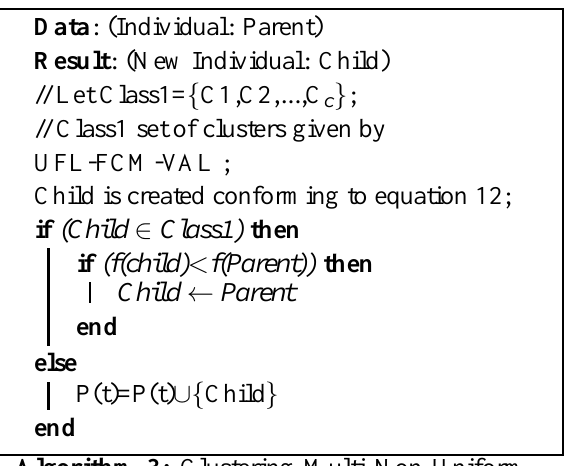
Algorithm 3: Clustering Multi Non